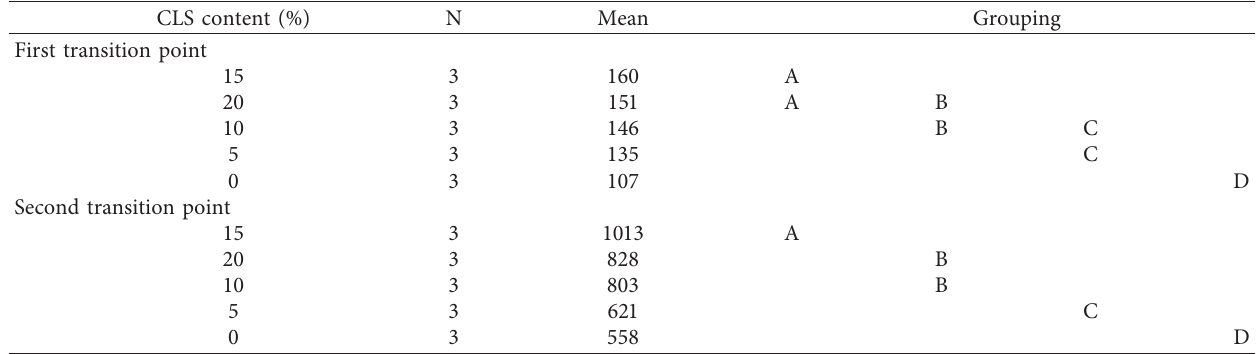
Table 13: Classification of transition points using the Tukey procedure with a confidence level of